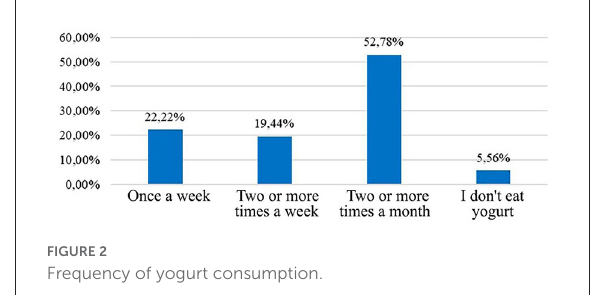
FIGURE2 Frequency of yogurt consumption.